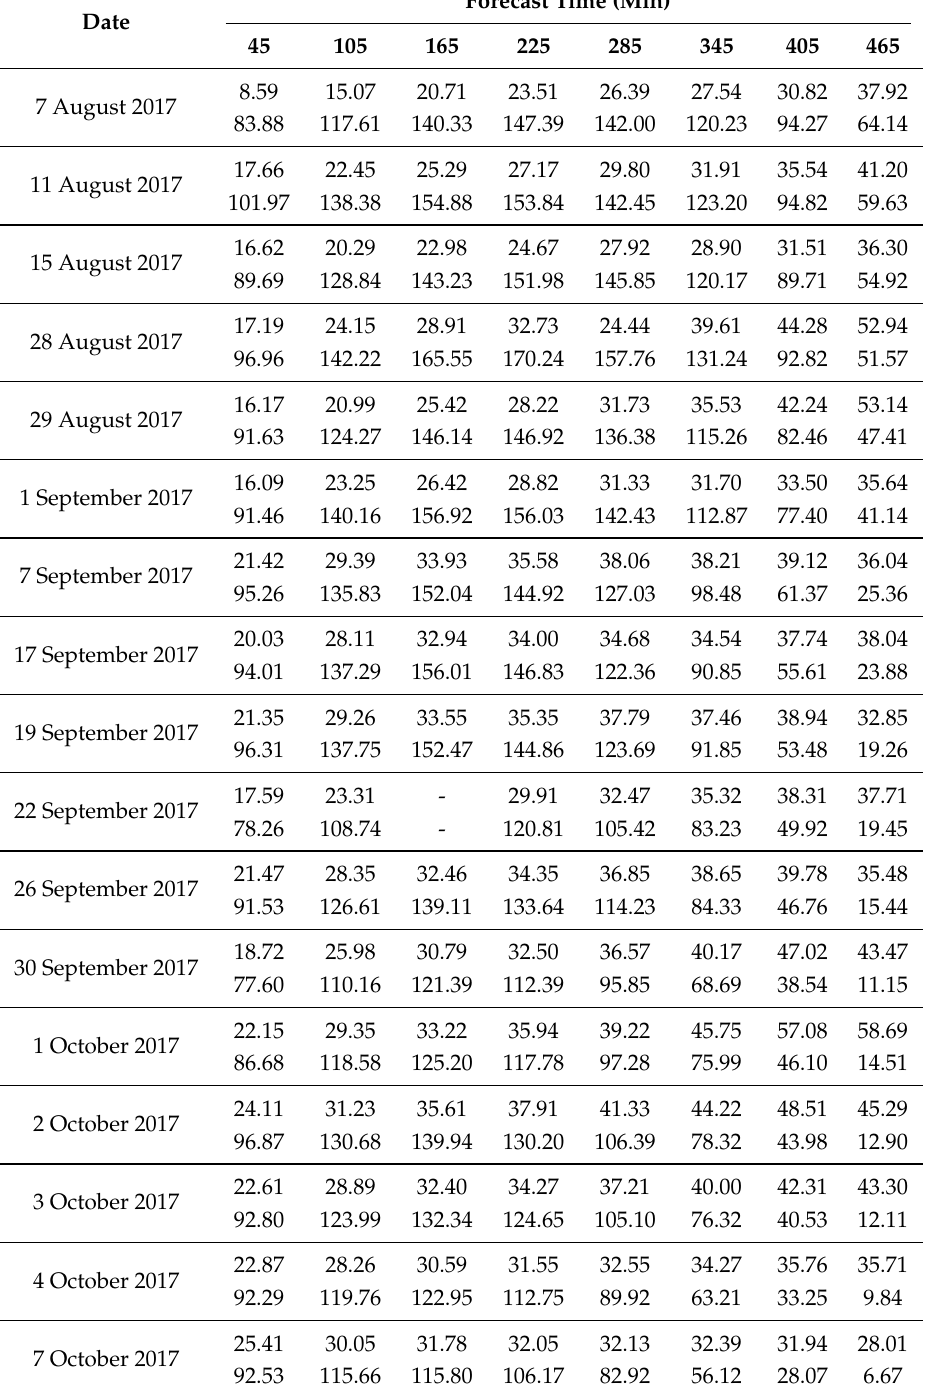
Table A4. Error measures of SARAH-2 validation for all cases up to 465 min of forecast time. These values were calculated for the area of Europe. The upper row for each date represents the relative RMSE in % and the lower one shows the RMSE in W/m 2